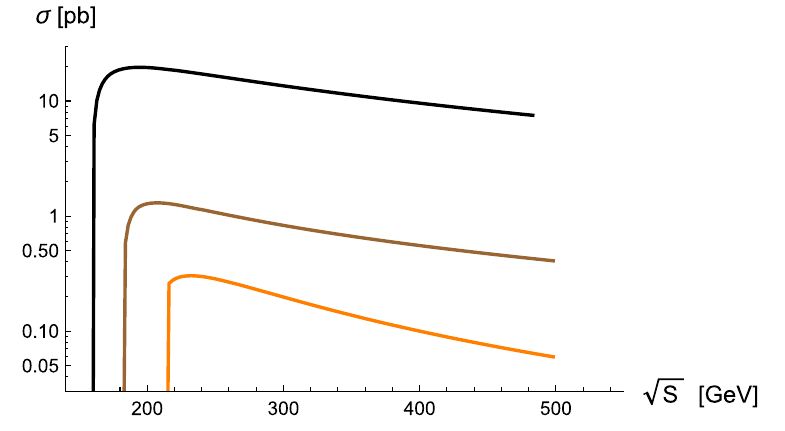
Fig. 5 The cross section for the SM background processes to our signal scenarios on time scales of ten to twenty years from now.